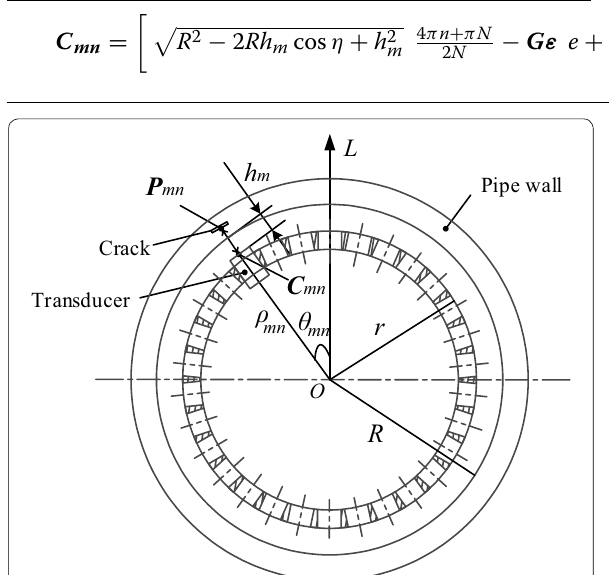
Figure 2 Two‑dimensional structural diagram of normal incidence transducer array